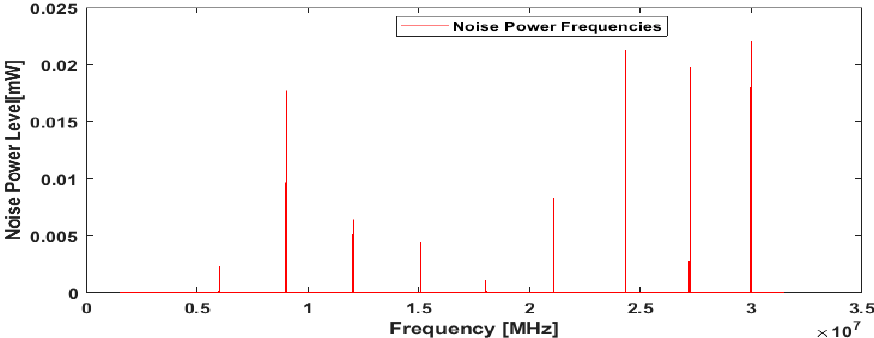
Figure 7. Electric Iron observed noise power from 3 MHz to 30 MHz.